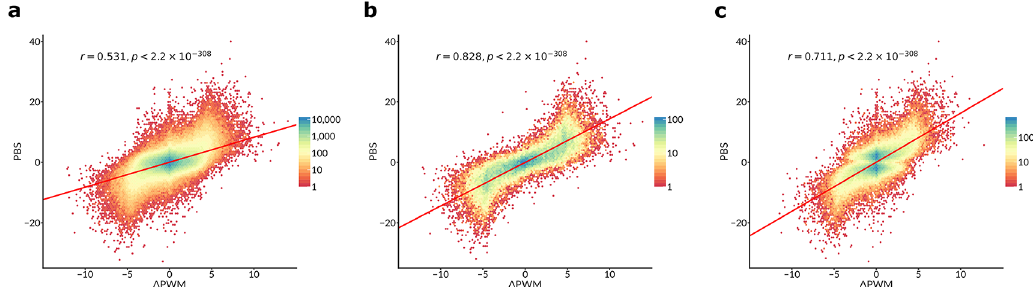
Figure 1. PWM predictions of differential TF binding to SNPs correlate with SNP-SELEX estimates. Hex-plots of PBS scores (Y-axis) vs Δ PWM CIS-BP predictions (X-axis) for different sets of SNPs, analogous to Figure 2a and Figure 3a in Yan et al. , with PCC and two-sided t-test P -values displayed. a. Complete set of 816594 TF-SNP pairs for 129 TFs that were used to compare the performance of deltaSVM vs Δ PWM in Yan et al. b. A subset of 35837 TF-SNP pairsoverlappingstrongPWMhits( P <10 -4